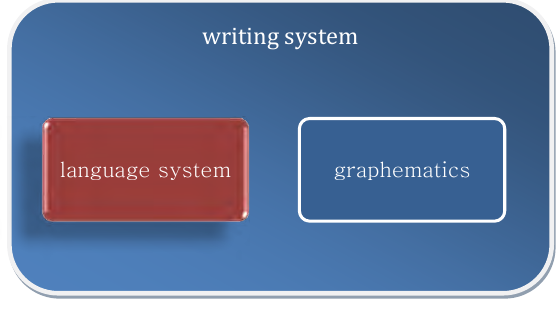
Figure 2: Structure of the writing system (graphematic